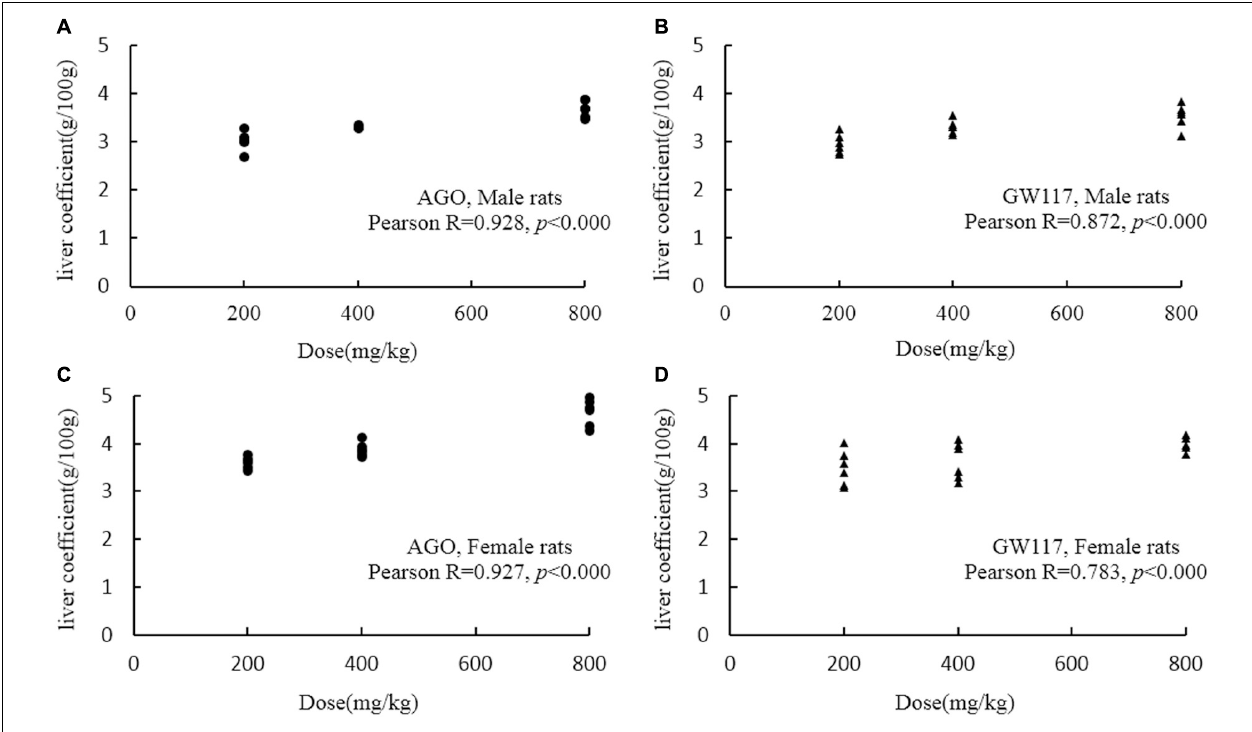
FIGURE 4 | Scatter graph and Pearson correlation coefficient between liver coefficient and doses of AGO or GW117 ( n = 6). (A) Correlation between liver coefficient and doses of AGO in male rats; (B) correlation between liver coefficient and doses of GW117 in male rats; (C) correlation between liver coefficient and doses of AGO in female rats; (D) correlation between liver coefficient and doses of GW117 in female